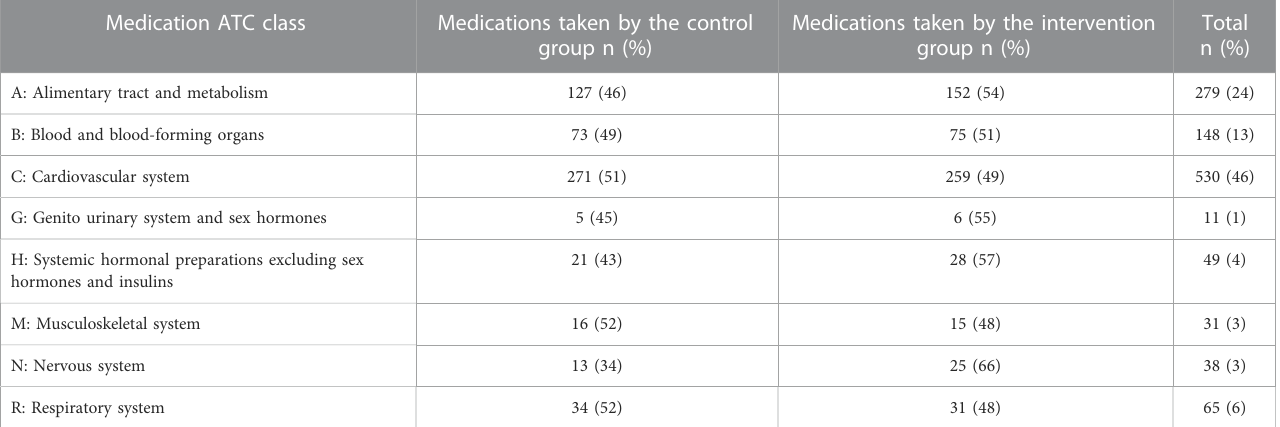
TABLE 3 Anatomical Therapeutic Classi fi cation (ATC) classi fi cation of medications among intervention and control two groups (World Health Organization, 2022). Medication ATC class Medications taken by the control Medications taken by the intervention group n (%) group n